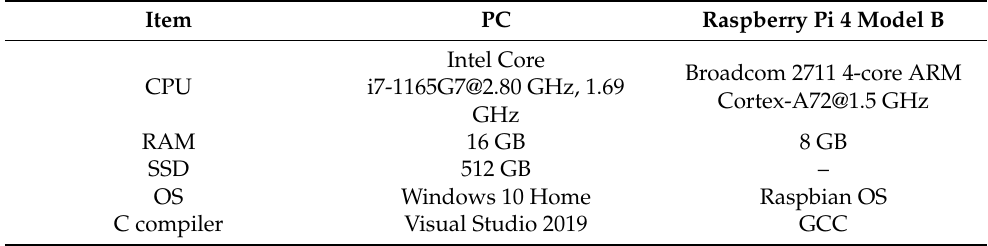
Table 2. Specifications of the PC and microprocessor used for comparison of the execution time of